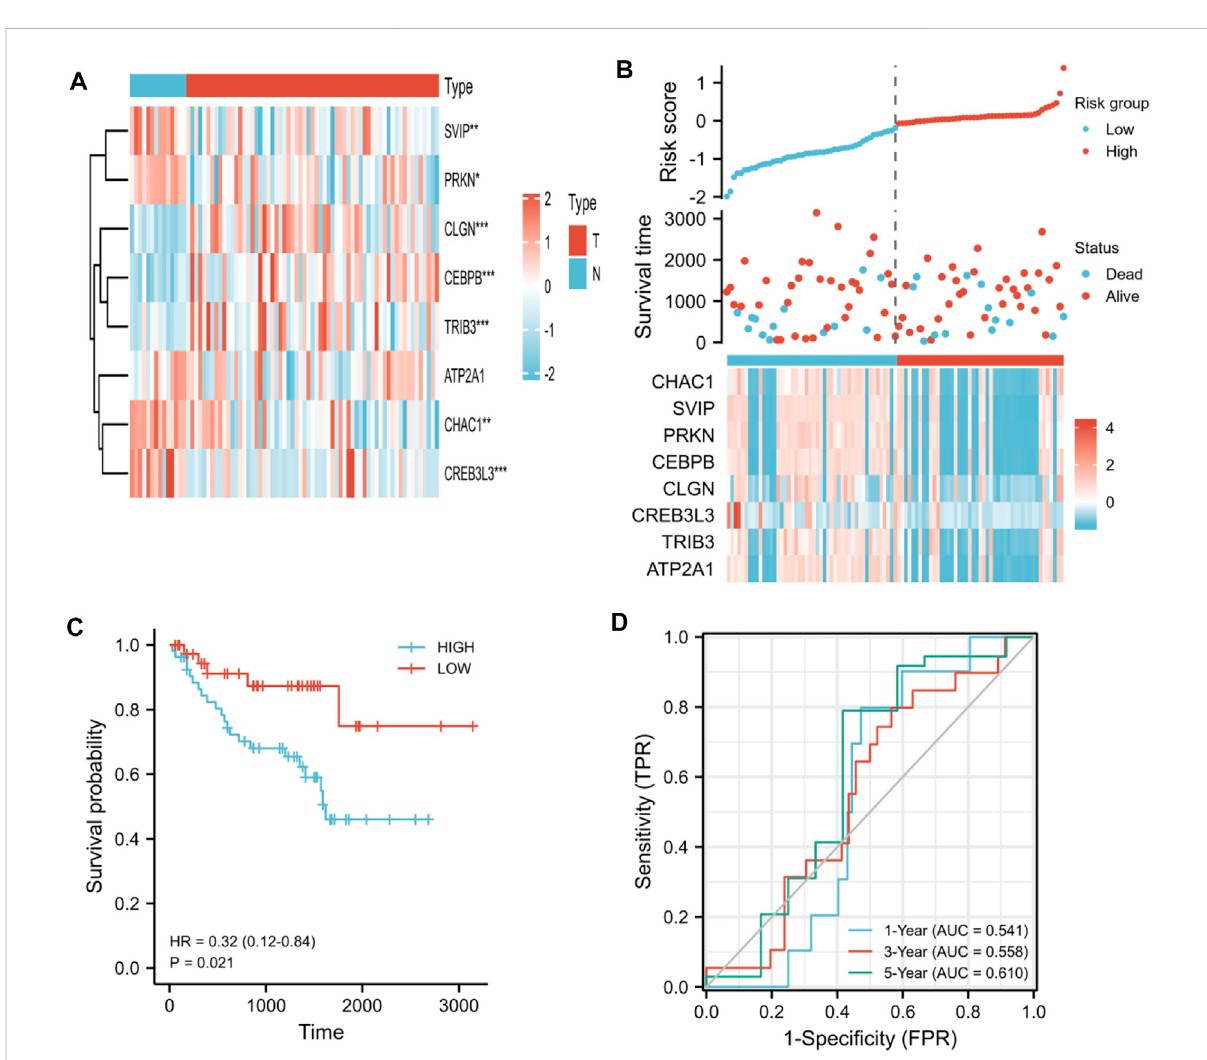
FIGURE 8 Validation of the prognostic ER stress-related gene model by using the patients from GSE29609 and GSE167573 datasets. (A) Heat map visualized differential expression of eight ER stress-related genes in tumor specimens (T) and normal specimens (N). Red means upregulated genes, and blue means downregulated genes. (B) Ranked dot and scatter plots showing the risk score distribution and patient survival status. (C) K-M analysisoftheOSbetweenthetworiskgroups. (D) ROCcurvestopredictthesensitivityandspeci fi cityof1-,3-,and5-yearsurvivalaccordingto the risk score. (* p < 0.05, ** p < 0.01, and *** p <